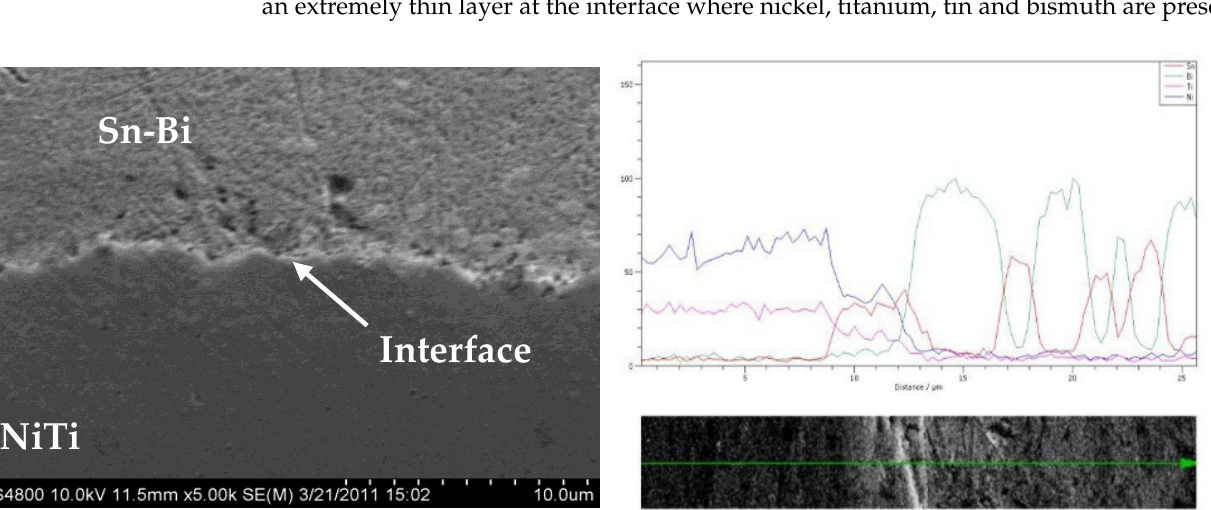
Figure 2. SEM image of Sn-20% Bi with a NiTi reinforcement (d = 500 µm) at ( a ) 300× and at ( b ) 1000× magnification. Reprinted/adapted with permission from Ref. [20]. 2013, Shobhit Misra.